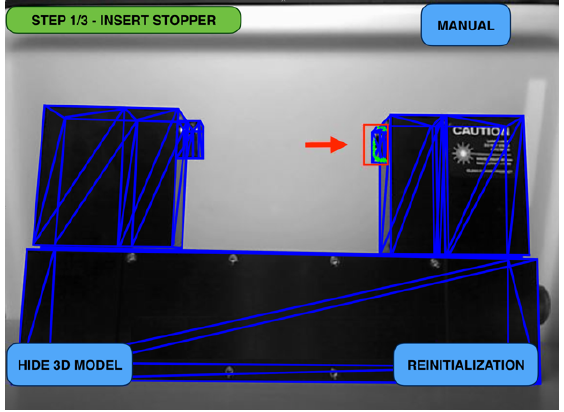
Figure 9. The graphic user